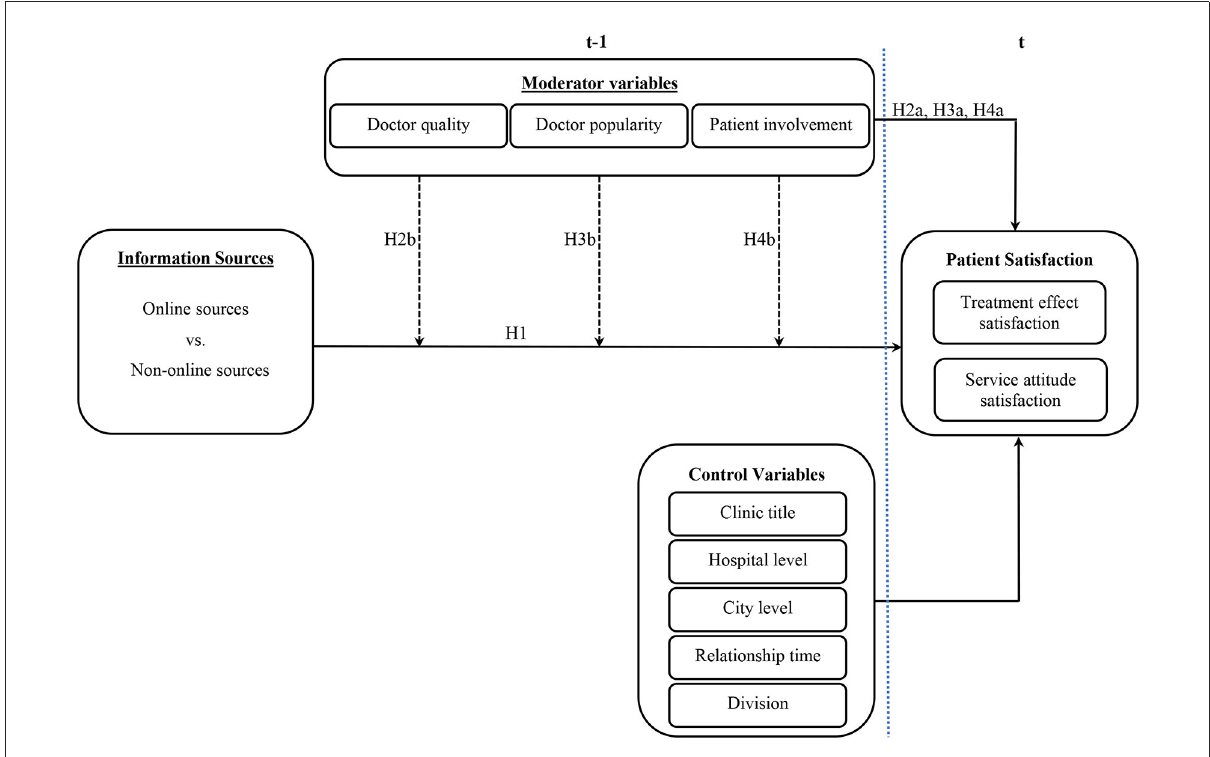
FIGURE1 Research